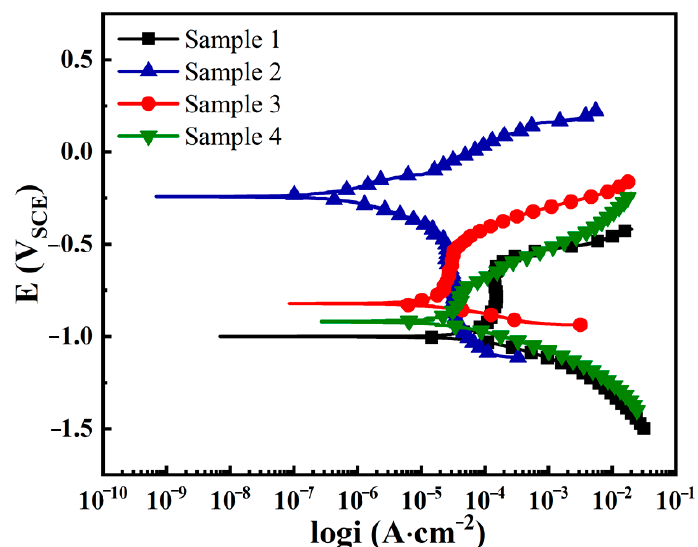
Figure 7. Potentiodynamic polarization curves of samples in 3.5 wt.% NaCl solution. Table 3. Electrochemical parameters extracted from potentiodynamic polarization curves (Figure 6). Sample